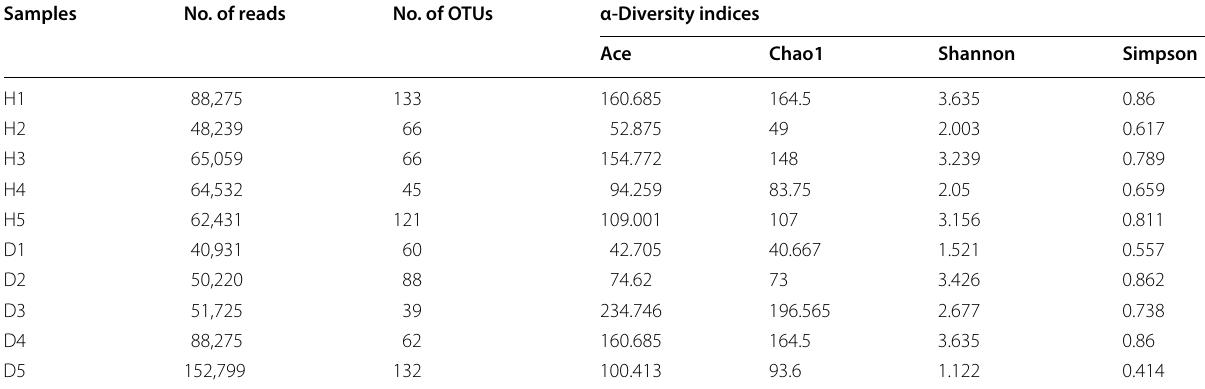
Table 1 Summary of sequence, OTU, and α-diversity Samples No. of reads